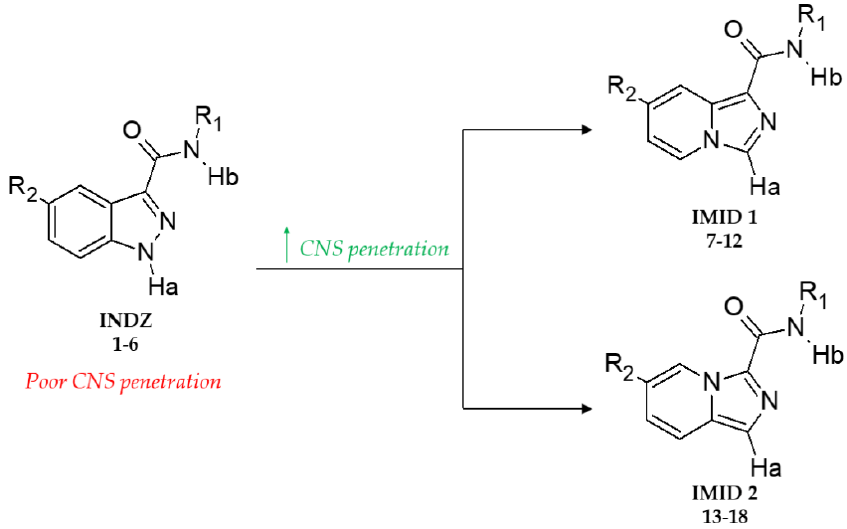
Figure 1. Exploration of IMID 1 and IMID 2 derivatives 7 – 18 starting from previous INDZ 1 – 6 to improve CNS penetration.